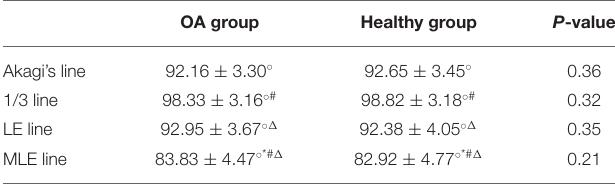
TABLE 1 | Comparison of the OA group and healthy group. OA group Healthy group P -value